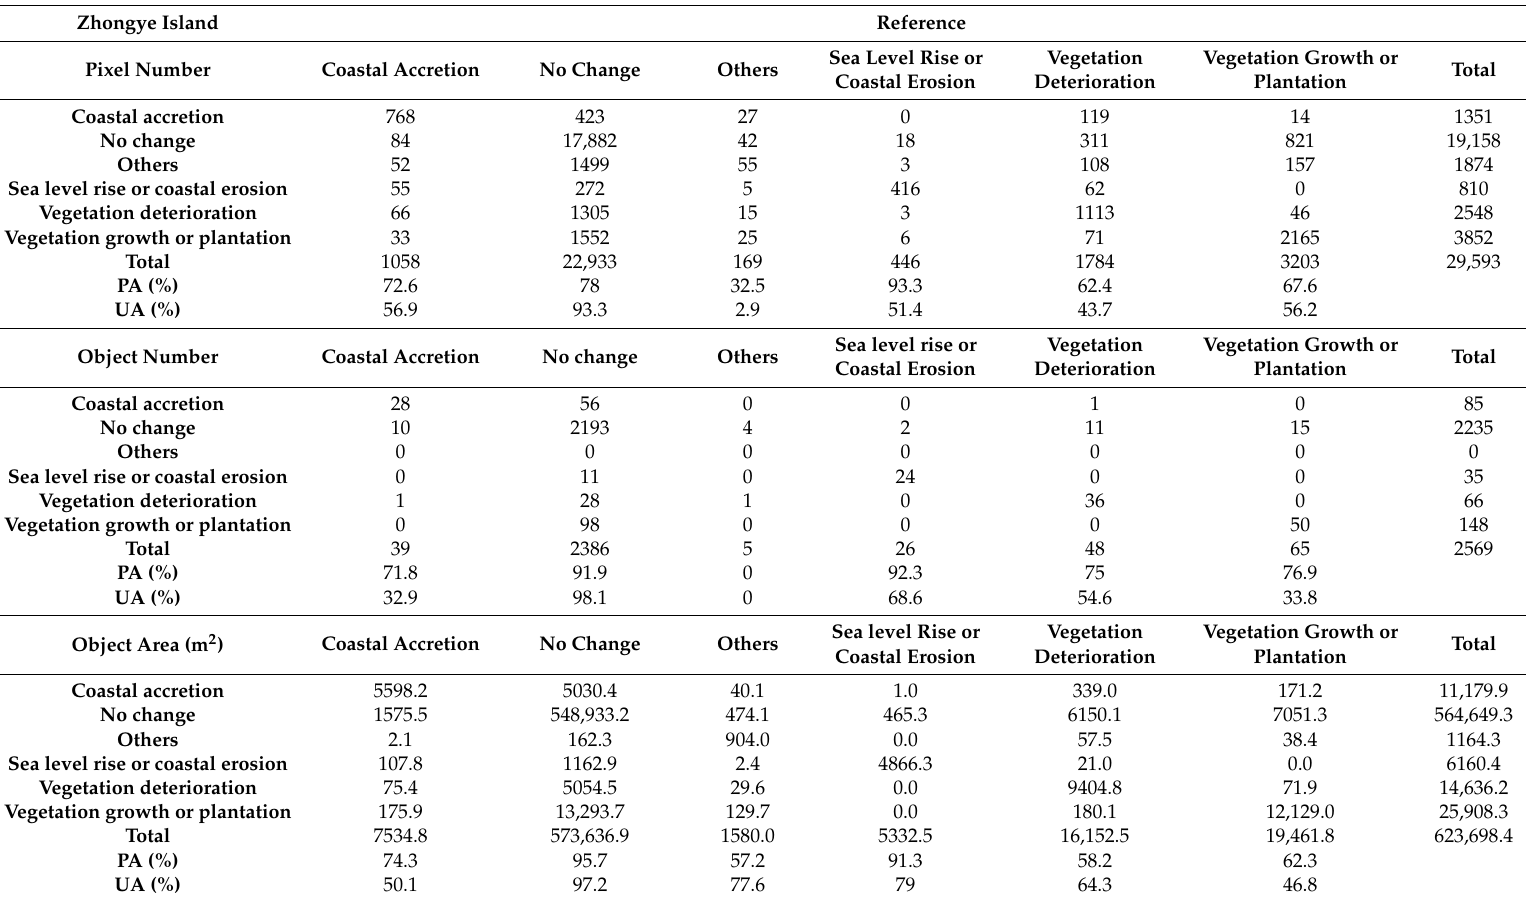
Table 4. Confusion matrices of PBCD and OBCD results for Zhongye